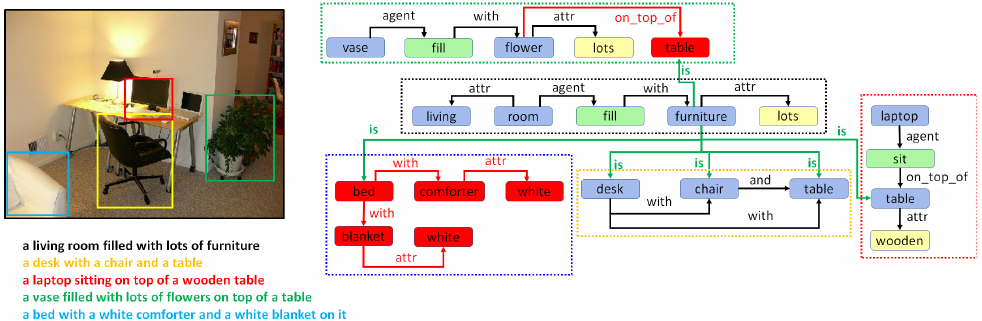
Figure 20. Holistic graph generation showing misclassification of partially occluded